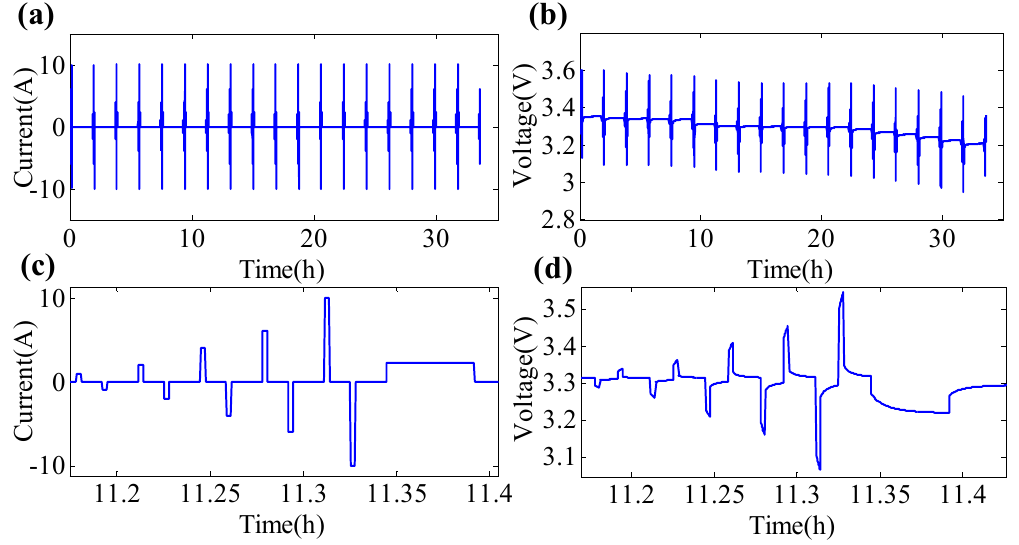
Figure 6. The hybrid pulse power characteristic HPPC (hybrid pulse power characteristic) test of the LiFePO 4 cell: ( a ) Current; ( b ) Voltage; ( c ) One current profile; ( d ) One voltage profile.